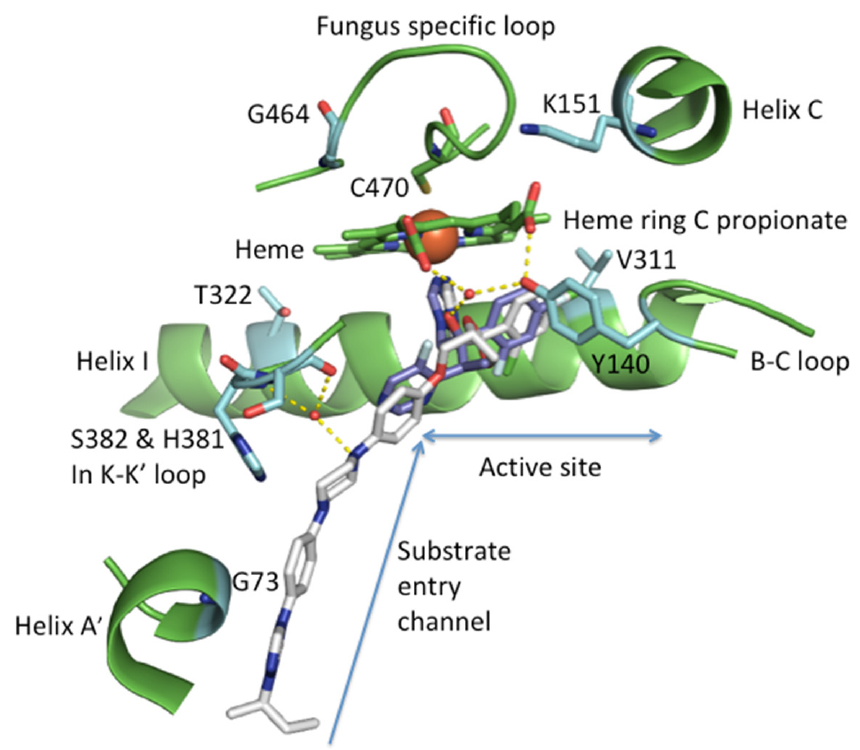
Figure 1. Structural view of the ligand-binding pocket of S. cerevisiae SDM (sterol 14-alpha demethy- lase) with the azole inhibitor short-tailed VCZ (voriconazole) and the long-tailed ITC (itraconazole) overlaid. The triazole of each drug is the 5th ligand of the heme iron (large red ball) and C470 is the 6th ligand. AA (amino acid) residues important for azole binding and/or azole resistance discussed in this review are shown with their carbons in light green. A list of this AAs is given in Supplementary Table S3. Relevant structural features, including the heme porphyrin, are given in green. Water-mediated hydrogen bond networks important for the binding of VCZ in the active site and ITC in the substrate entry channel are shown as yellow dashes. Table 1. Pathogenic fungi with naturally occurring amino acid (AA) substitutions in the active site of sterol 14 α -deme- thylase (SDM; CYP51 enzyme of the cytochrome P450 superfamily) and correlated azole resistance.